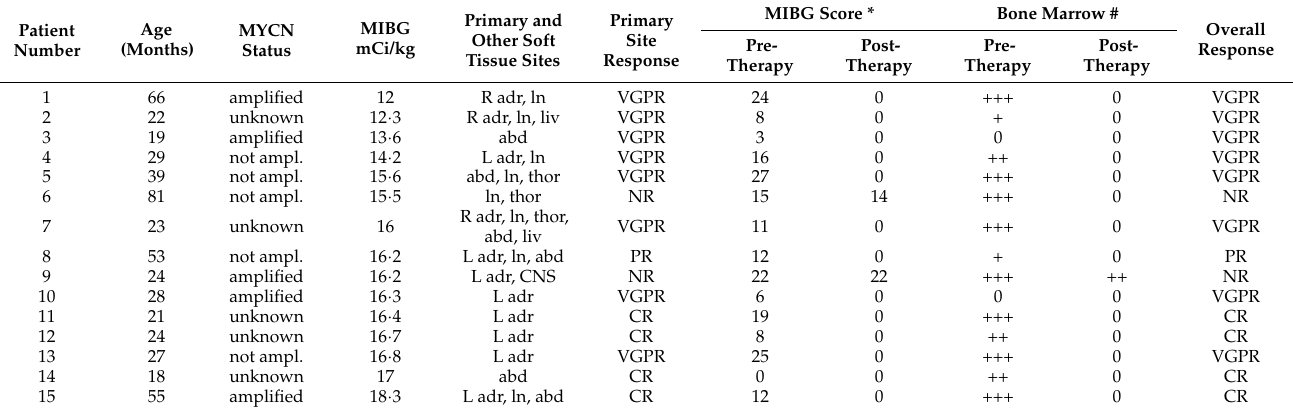
Table 1. Patient characteristics, dose of 131-I-MIBG administered, and response to